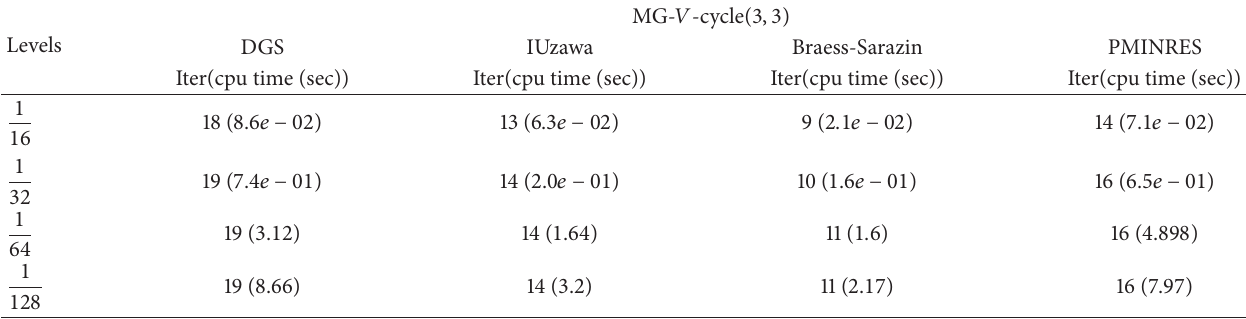
Table 4: Number of iterations and CPU time for multigrid ( 𝑉 -cycle) with different smoothers and smoother preconditioner approximations at different levels of refinement, tolerance = 10 −6 .